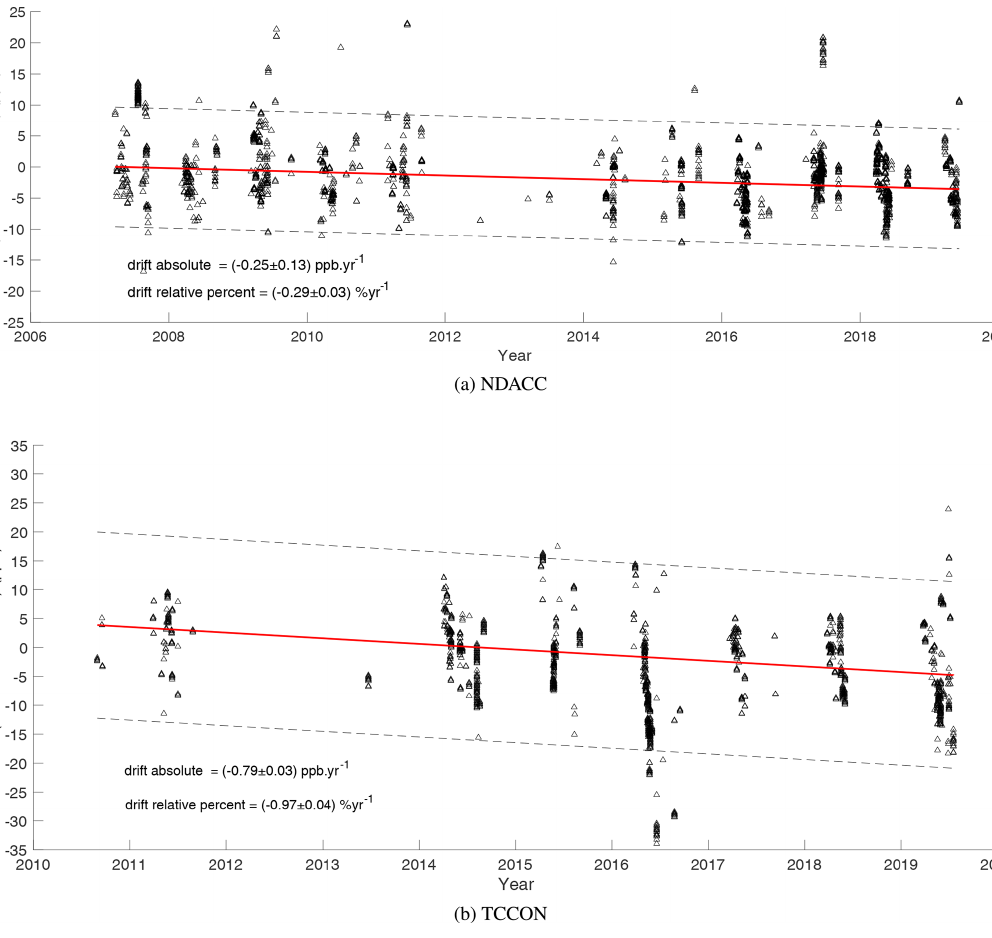
Figure 10. Sample temporal evolution of bias in the MOPITT CO total column relative to (a) NDACC and (b) TCCON corresponding to Fig. 9. The red lines indicate bias drift calculated from a bi-square weighted robust fitting method. The dashed black lines are 2 σ